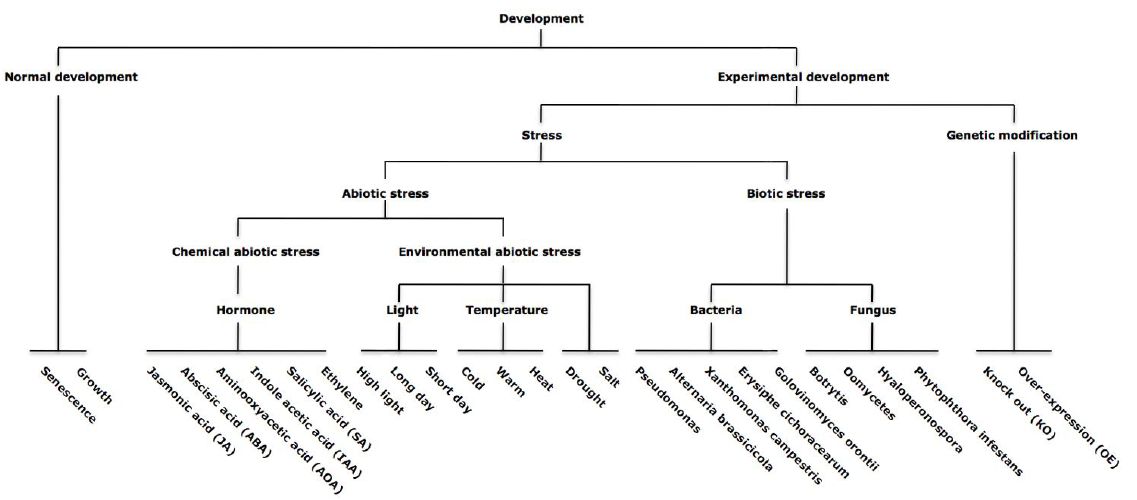
Figure 2: An ontology of biotic and abiotic causes of plant stress responses.